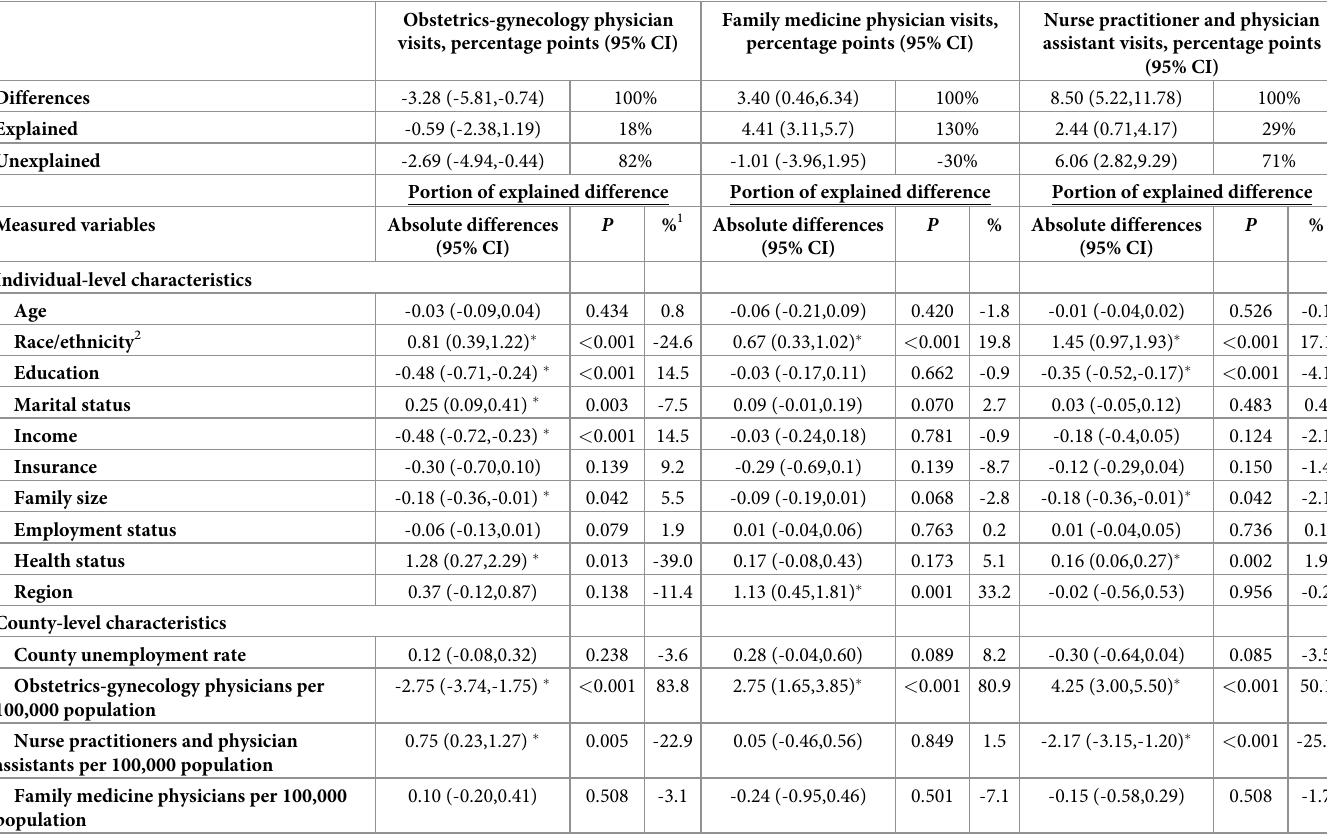
Table 4. Blinder-Oaxaca linear decomposition results for rural/urban disparities in obstetrician-gynecologist and nurse practitioner/physician assistant visits among women age 18 to